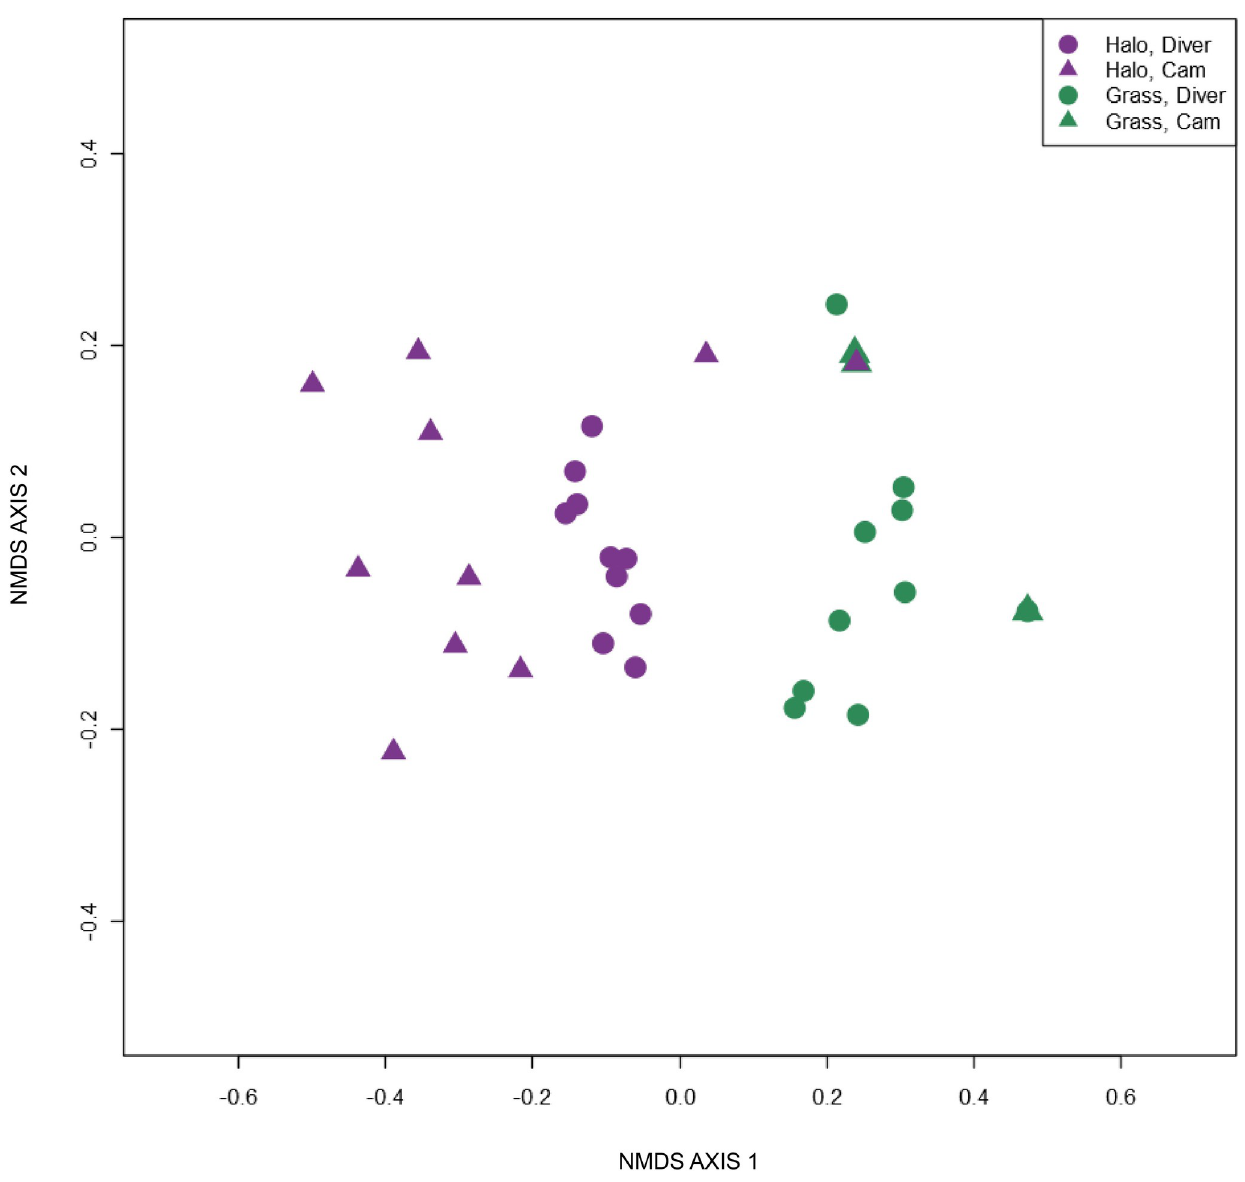
Fig 5. Non-metric multidimensional scaling (NMDS) based on presence/absence data. Points represent 20 individual site observations by divers or 3 pooled images from 18 given sites and are colored purple for halo/reef cameras and dark green for seagrass or algae cameras. ANOSIM of this NMDS output found a significant difference between halo/reef (purple) and seagrass/algae (green) communities (R = 0.68, p < 0.001). Dots represent diver observations, while triangles represent camera images. Both diver and camera observations reflect the same clear difference between fish communities on the reef and those in the seagrass. See S5 Fig for a stressplot of this